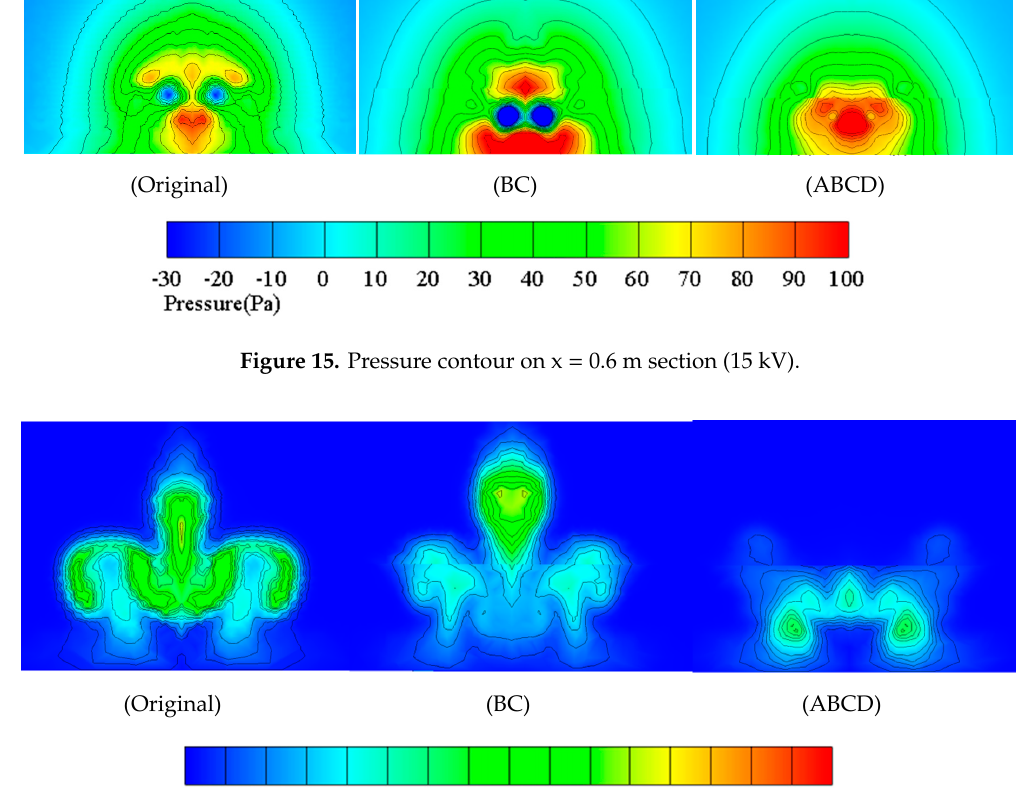
Table 2. Optimal design parameters.